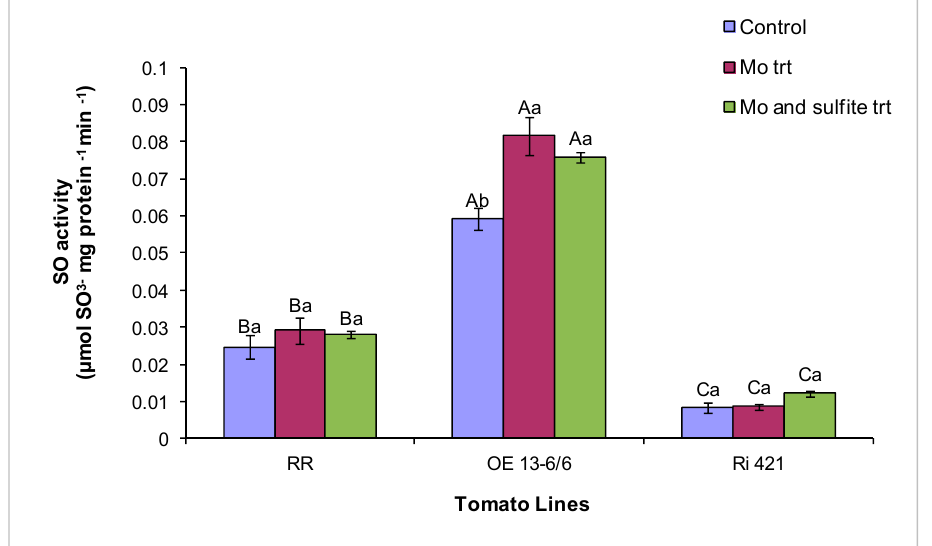
Figure 6. E ff ect of sulfite application on Mo sprayed and non-sprayed tomato lines. The shoot tips of control and Mo sprayed plants were kept in a 3 mM Na 2 SO 3 solution for 8 h. SO enzyme activity was analyzed by using 2 µ g of crude protein per assay. Values are means ± SE ( n = 4–6). Di ff erent letters show significant di ff erences, p < 0.05. Upper case letters represent the e ff ect between tomato lines and the lower case letters represent the e ff ect between pretreatments within the